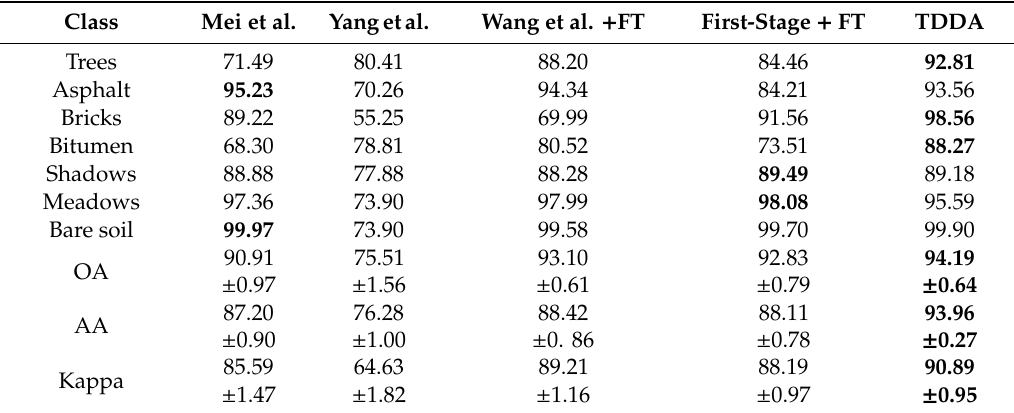
Table 6. Classification accuracy and kappa (%) on Pavia University → Pavia Center